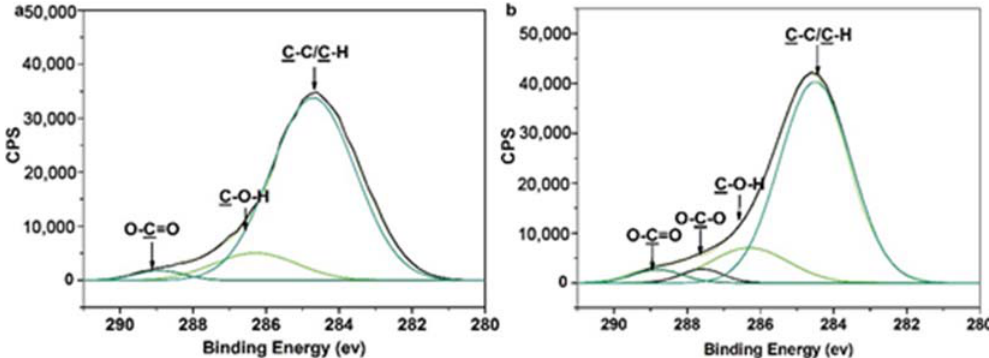
Figure 3. High-resolution XPS spectra of C 1s: a, the POEGMA-modified MPPM (POEGMA GD = 350  g/cm 2 ) and b, the galactose-modified MPPM (POEGMA GD = 350  g/cm 2 , glyocosyl BD = 1.603 nmol/cm 2 . (Peak area (%): a , C–C/C–H: 88.69%, C–O–X: 7.27%, O–C=O: 4.05%); b , C–C/C–H: 83.96%,